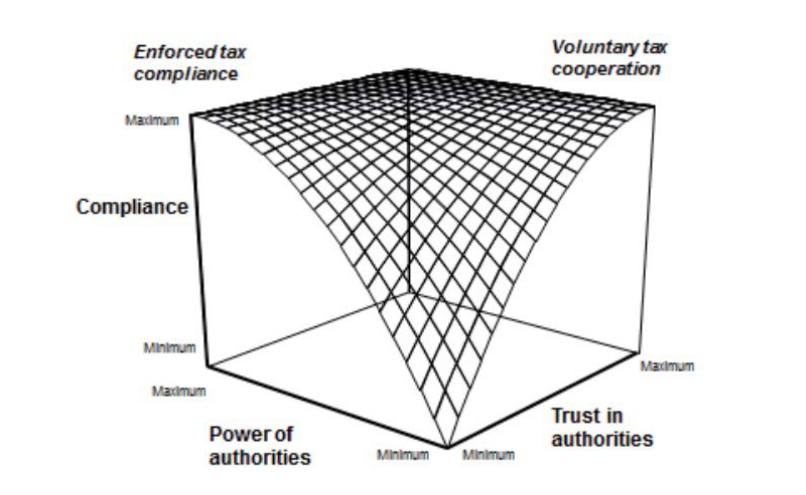
FIGURE 1: The slippery slope framework of tax compliance Source: Kirchler, Hoelzl, and Wahl